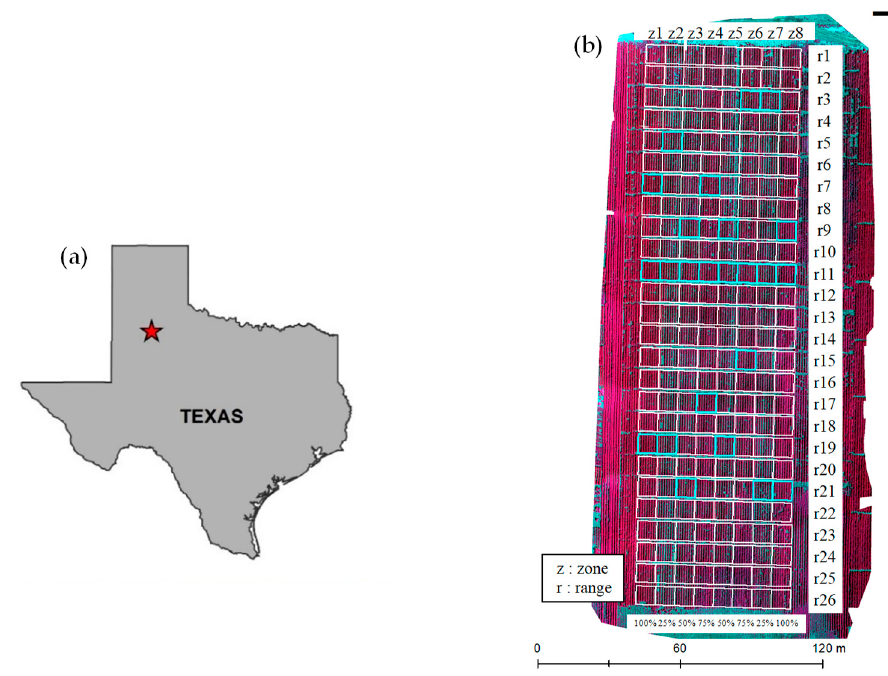
Figure 1. ( a ) the location of the study area (Lubbock, Texas); ( b ) NIR, red and green false-color composite image offered by MicaSense sensor to show the experimental design. The plots surrounded by cyan squares are places where in-situ stem water potential was measured during the cotton growing season.